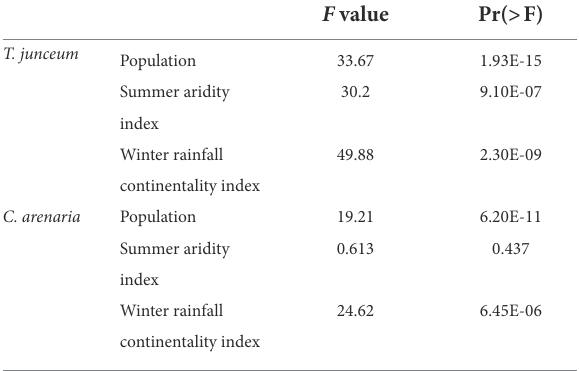
variation in seed germination, varying from 5 to 54% according to germination conditions, while for seed mass it was lower than 40%.